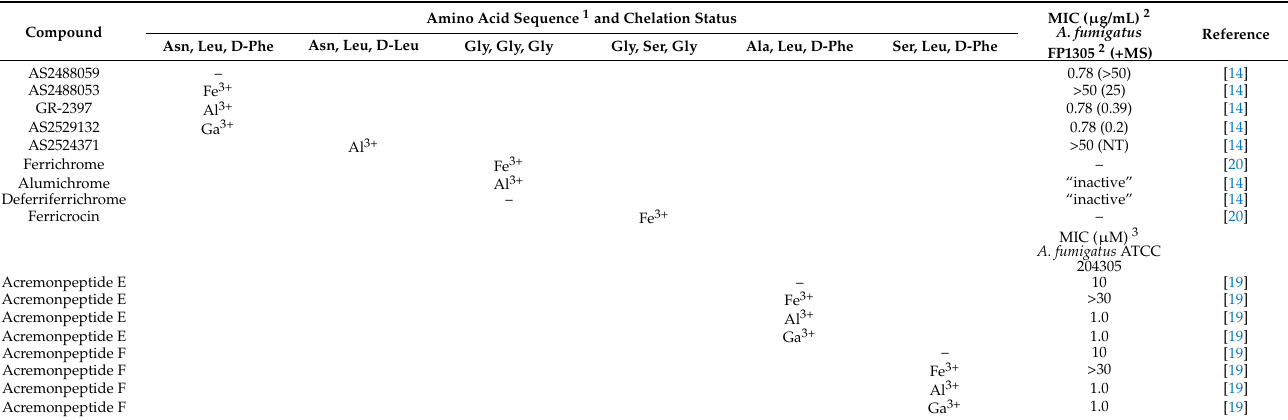
Table 1. Structure and activity of siderophore